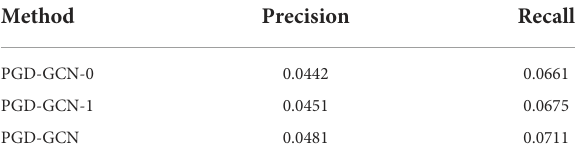
TABLE 5 Results of variants on Yelp.